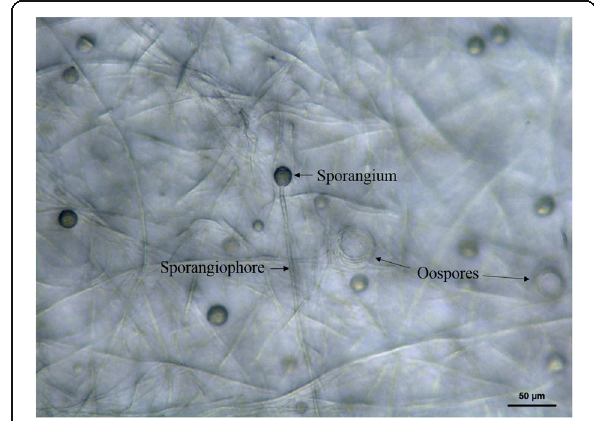
Fig. 2 Hyphae, sporangia, sporangiophore and oospores imaged with a Zeiss Axio Zoom V16 microscope using base illumination with relief contrast, dark-field and bright-field modes and epi-illumination with a Schott LED ring light to catch intact images of fruiting bodies of Pythium irregulare . This image was captured without opening culture plate at Bessey Microscope facility (currently, Microscopy